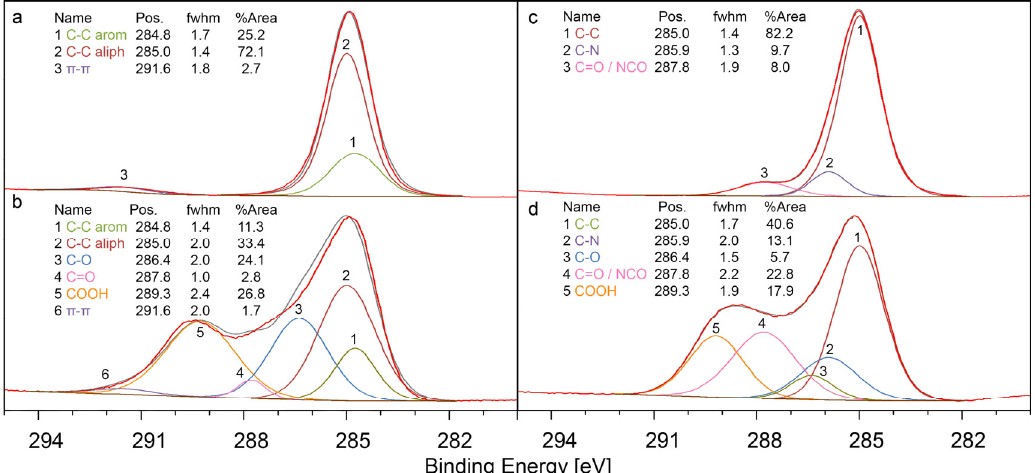
Figure 4. XPS data of the C 1s signals. ( a ) Unmodi fi ed PS surface. ( b ) PS surface after exposure to a plasma jet containing acrylic acid. ( c ) Unmodi fi ed PA 12 surface. ( d ) PA 12 surface after plasma jet modi fi cation with acrylic acid. The spectra were normalized (min to max). C-C arom: aromatic carbon in PS. C-C aliph: aliphatic carbon in PS.